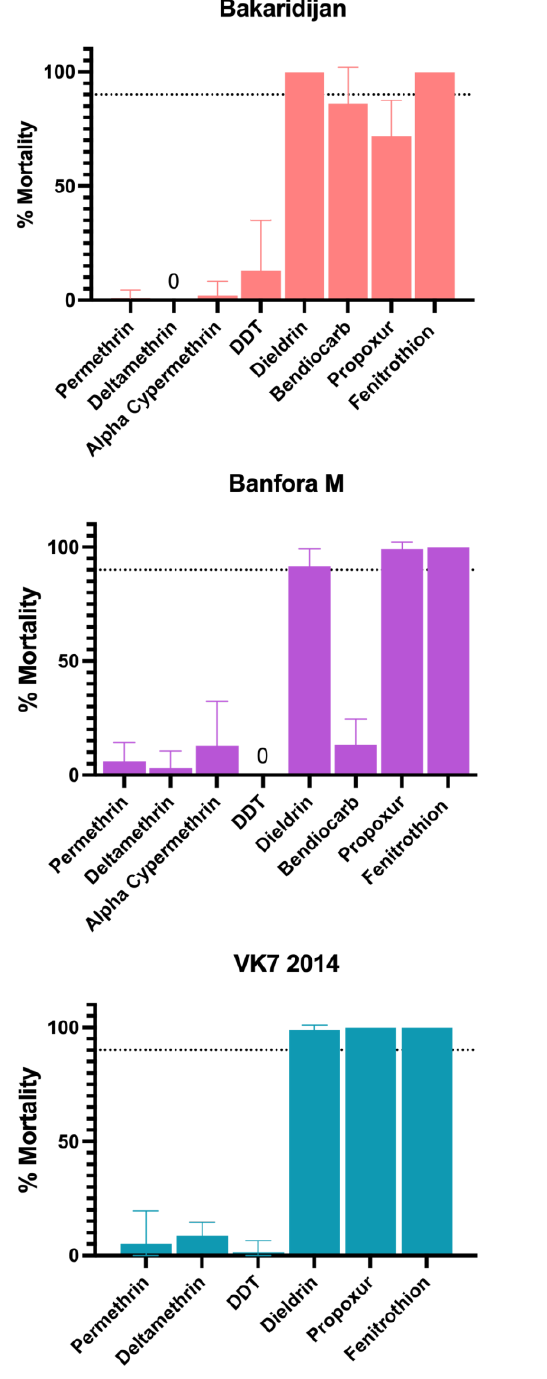
Figure 2. Mosquito mortality following exposure to insecticide papers in discriminating dose assays Mortality rates (%) 24 h after exposure for 5 strains of Anopheles mosquito (results shown from assays performed in 2019). Minimum sample size n = 80. Error bars represent 95% confidence intervals. Dotted line represents the WHO 90 % mortality resistance threshold.